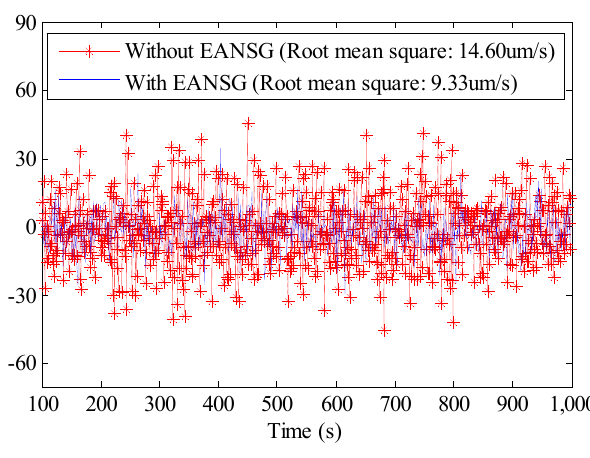
Figure 20. Experimental results of velocity.